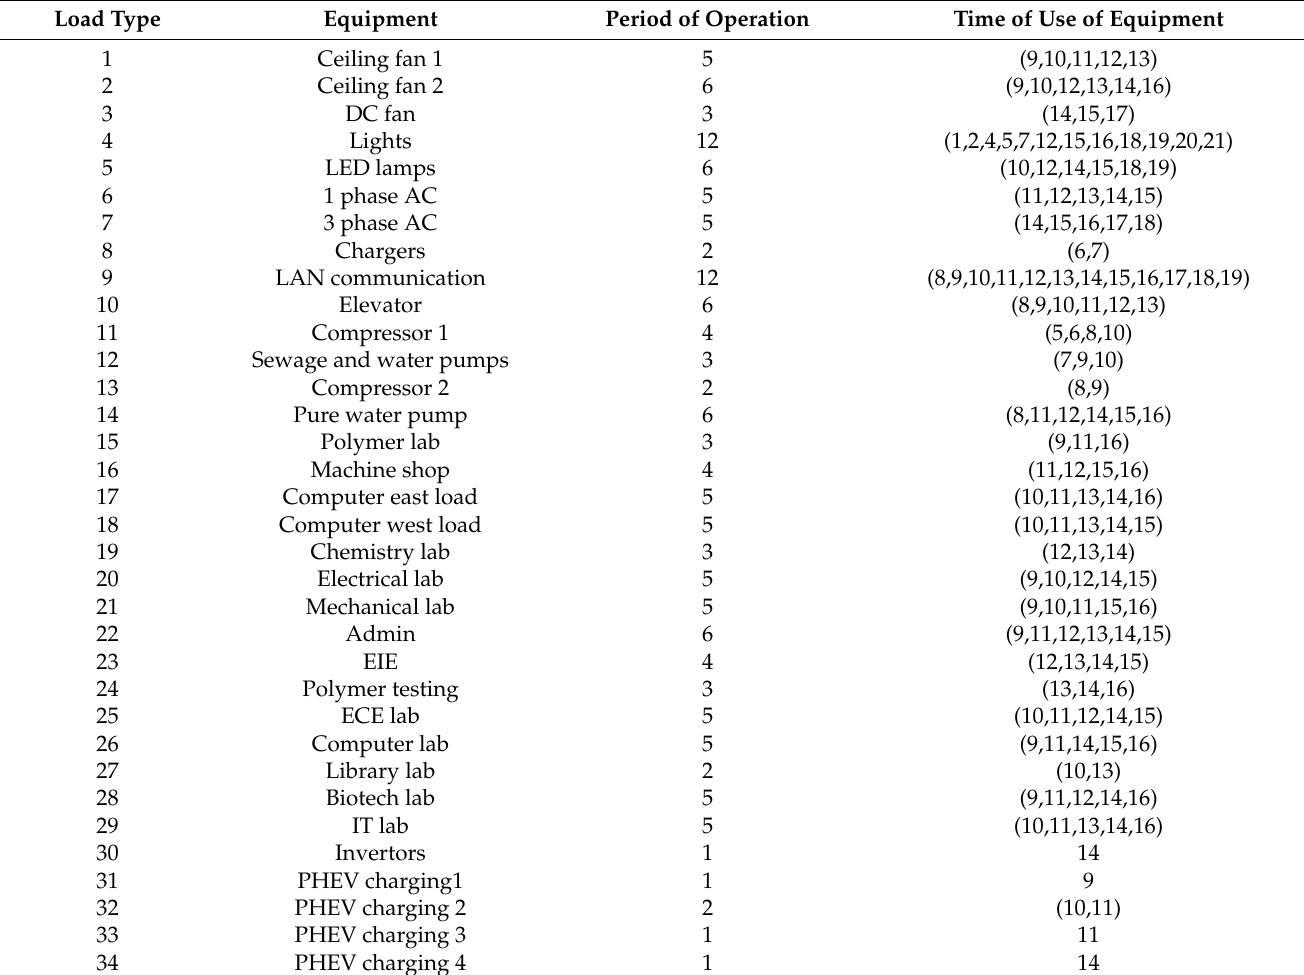
Table 2. Time of use of